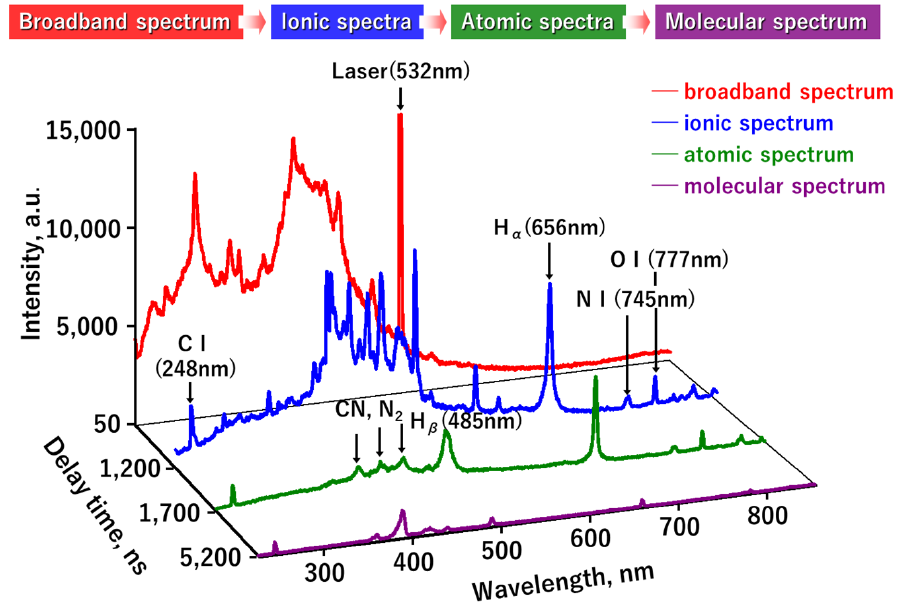
Figure 9. LIBS spectrum at each stage (A/F = 18). The spectra observed varied with the measurement delay time of the ICCD camera.